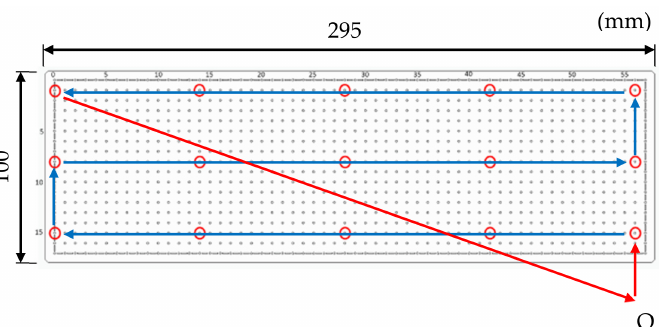
Figure 27. The calibration artifact with a pitch circle of 5 mm mounted on the platform of XY stage. The origin and 15 point track viewed from a stationary